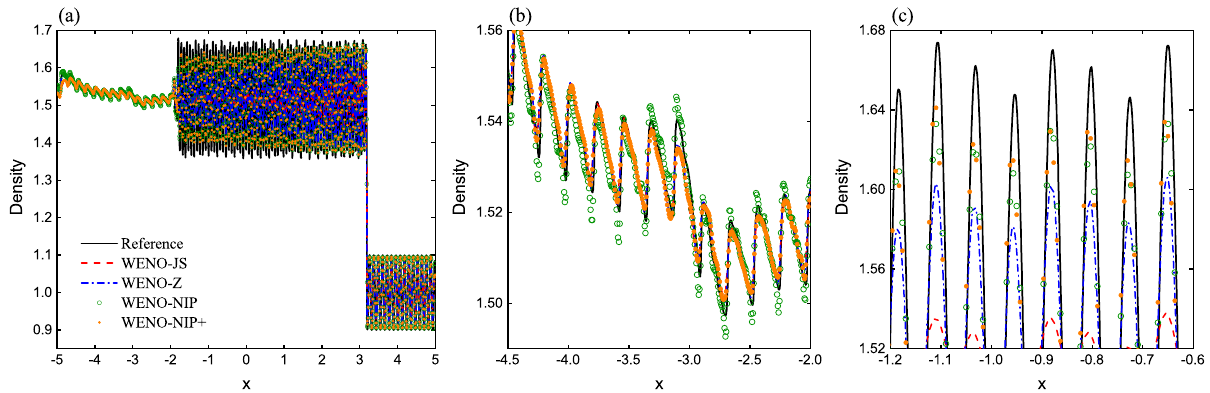
Figure 21. ( a ) The cross-sectional slices of density plot along the plane y = 0.0 for the 2D shock- density wave interaction of Titarev and Toro. ( b ) Zoom in near the region behind the high-frequency waves. ( c ) Zoom in near the high-frequency